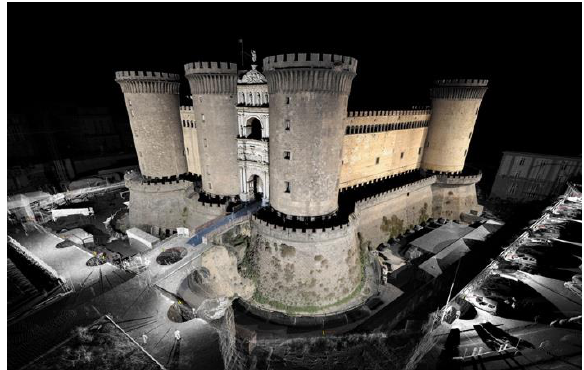
Figure 12. South-west view of the acquired dot cloud, indicating the scanning